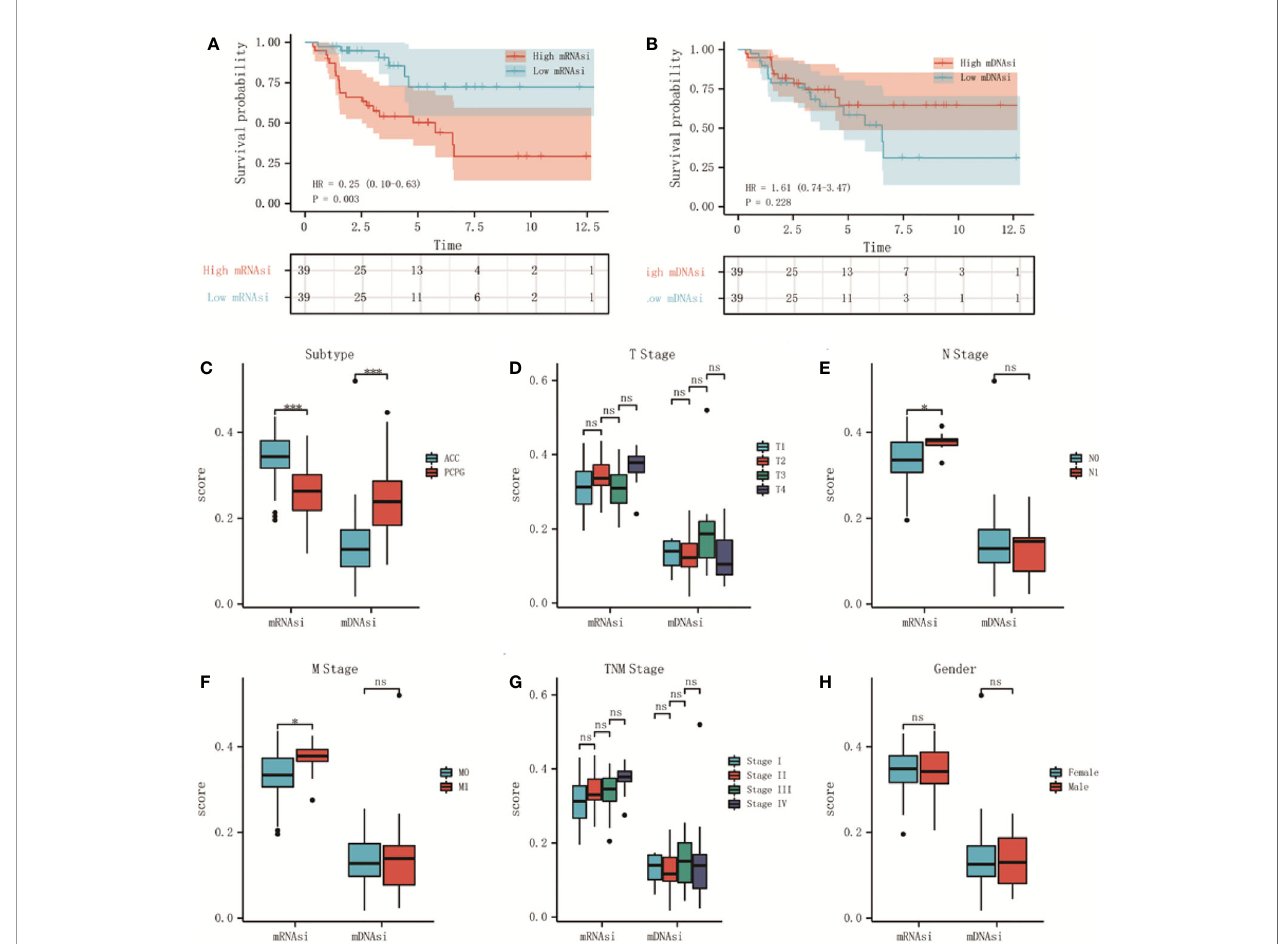
FIGURE 1 | The relationship between stemness indexes (mRNAsi and mDNAsi) and prognosis and clinical characteristics in adrenal tumors. (A, B) Kaplan – Meier OS curves for ACC (A) and PCPG (B) patients with low and high mRNAsi based on the median cut-off point. (C, D) Kaplan – Meier OS curves for ACC (C) and PCPG (D) patients with low and high mDNAsi based on the median cut-off point. (E) Boxplot of mRNAsi and mDNAsi in individual samples of ACC and PCPG patients. (F – J) Boxplots of mRNAsi and mDNAsi in individual samples of ACC strati fi ed by T stage (F) , N stage (G) , M stage (H) , tumor stage (I) , and gender (J) . ***P < 0.001; ns, not signi fi